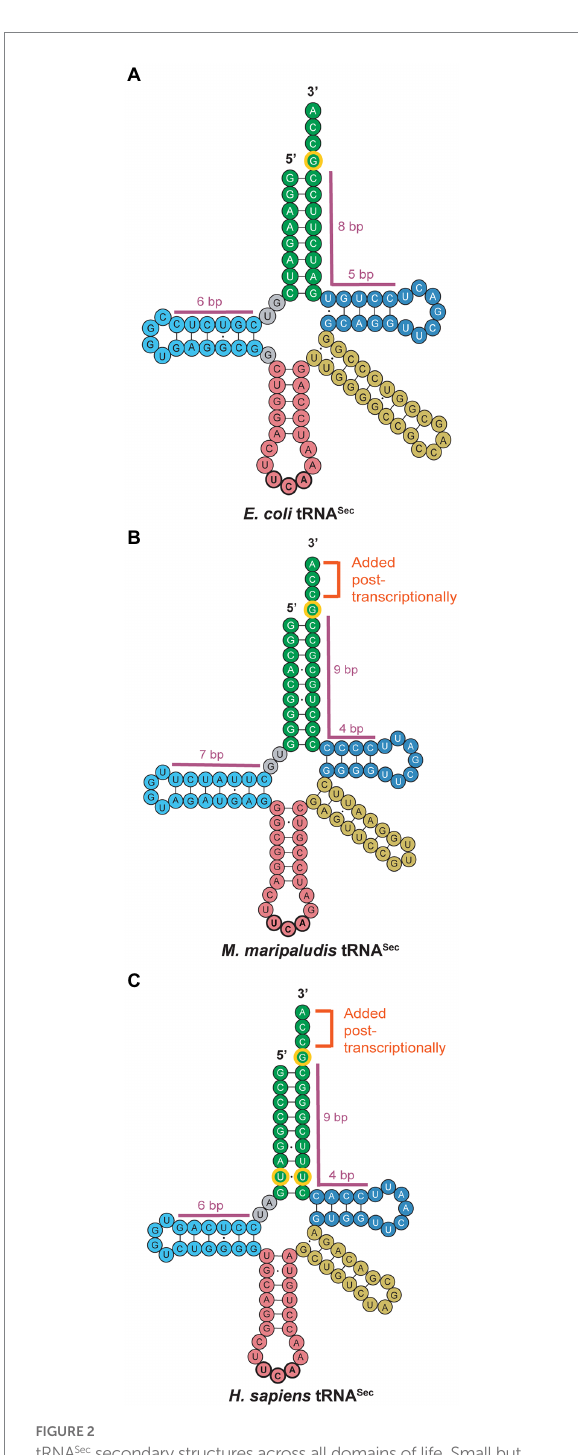
FIGURE 2 tRNA Sec secondary structures across all domains of life. Small but conserved differences are observed between (A) bacterial, (B) archaeal, and (C) eukaryotic tRNA Sec . While canonical archaeal and eukaryotic tRNA Sec share the post-transcriptionally added CCA tail and the 9/4 configuration of the acceptor stem (green) and T-arm (dark blue), archaeal tRNA Sec possesses a longer D-arm (light blue) than both bacterial and eukaryotic tRNA Sec . The tRNA Sec for all three domains share the G73 discriminator base as an identity element (outlined in yellow), but eukaryotic tRNA Sec also has a conserved U6:U67 base pair. Note that exceptions to the canonical archaeal tRNA Sec shown in this figure have been